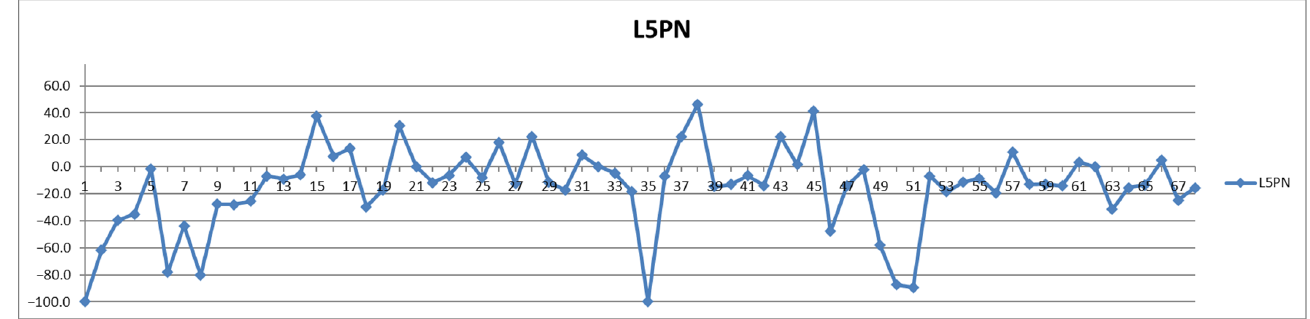
Figure 4. The food intake effect on small LDL particle number L5PN subfraction as difference be- tween postprandial and fasting concentrations as percentage relative to fasting concentration.